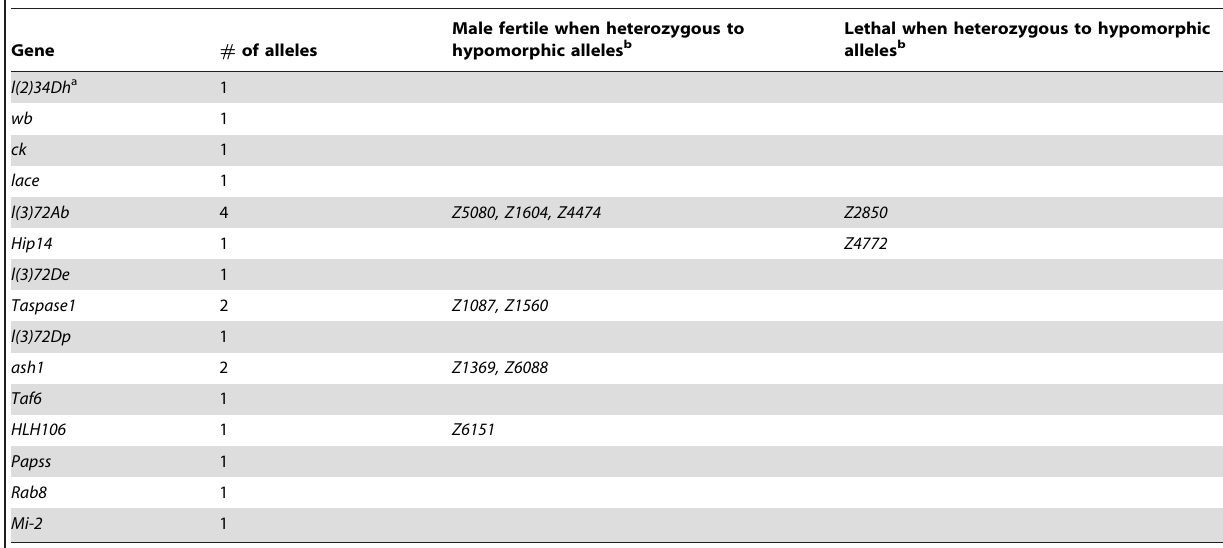
Table 4. Lethal alleles of vital genes from the Zuker collection.